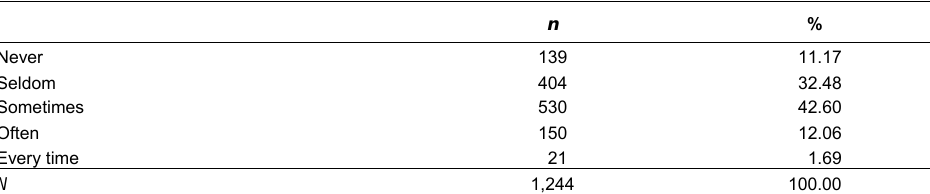
Table 8 : Were your expectations fulfilled when you met the partner offline? Sometimes 530 42.60